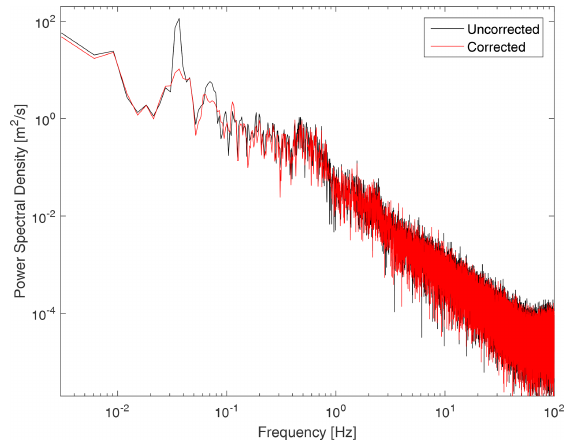
Figure 3. Power spectrum of horizontal wind magnitude calculated from uncorrected and corrected time series.